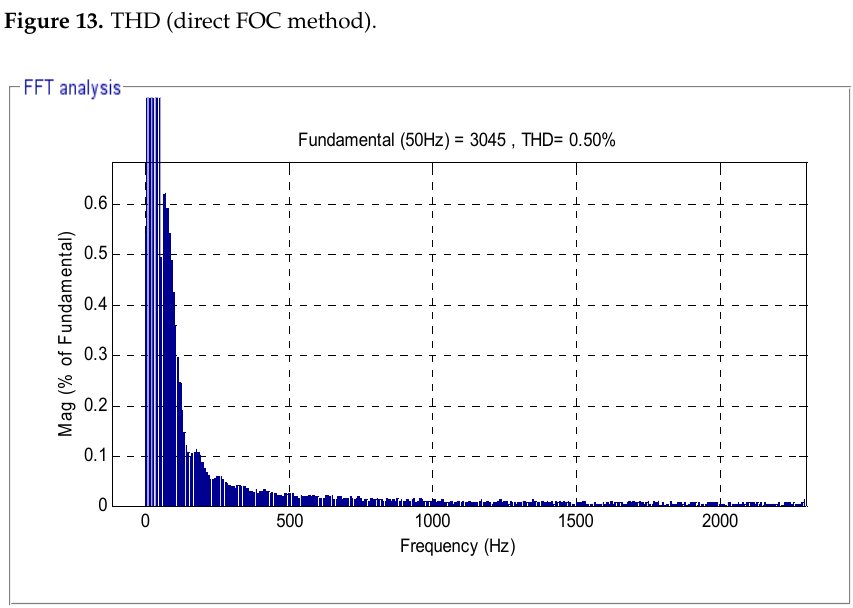
Figure 14. THD (direct FOC-SSMC control).